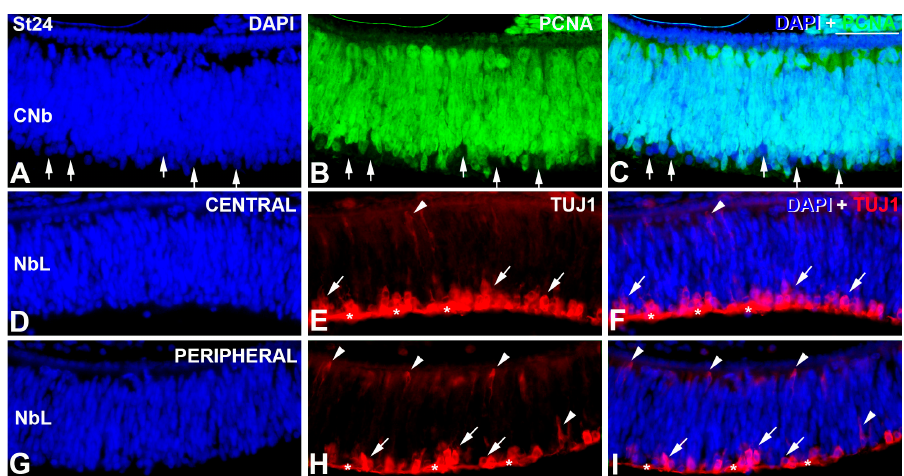
Figure 2. PCNA ( A – C ) and TUJ1 ( D – I ) immunoreactivity in retinal cryosections of C. coturnix at St